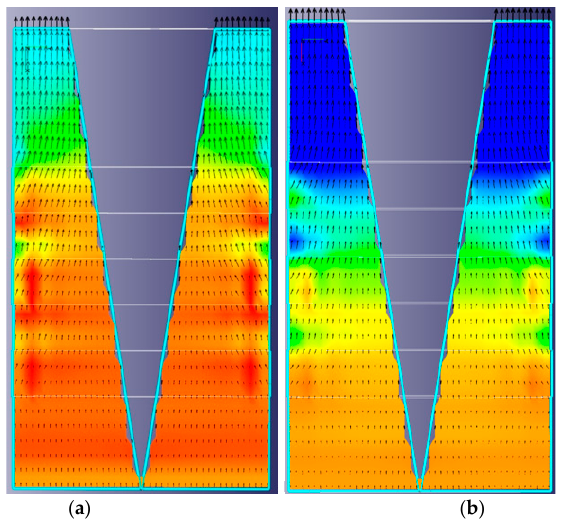
Figure 3. Distribution of air flow velocity and pressure in a vertical channel, which narrows at ( a )— 𝑉 (cid:3017) = 5 m/s; ( b )— 𝑉 (cid:3017) = 9 m/s.